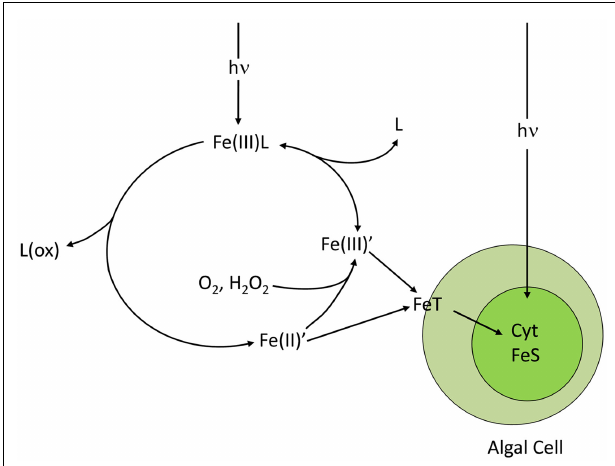
FIGURE 6 | Photo-redox cycling of ferric chelates (Fe(III)L), such as photoactive siderophore complexes. The cycle is initiated by the absorption of light by the ferric chelate and a subsequent photolytic reaction in which the iron is reduced to Fe(II) and the ligand is oxidized.The Fe(II) dissociates from the degraded chelate to give dissolved inorganic ferrous species (Fe(II) (cid:2) ) which are then rapidly oxidized to dissolved inorganic ferric hydrolysis species (Fe(III) (cid:2) ) by molecular oxygen and hydrogen peroxide.The Fe(III)’ is then re-chelated by the ligand to reform the ferric chelate.The cycle increases the uptake rate of iron by algal cells by increasing the steady state concentrations of biologically available Fe(II) (cid:2) and Fe(III) (cid:2) .The transport systemT directly accesses Fe(II) (cid:2) and indirectly accesses Fe(III) (cid:2) by reduction to Fe(II) (cid:2) . Once inside the cell, much of the iron is used for synthesis of cytochromes (Cyt) and Fe-S redox centers, needed in high amounts in